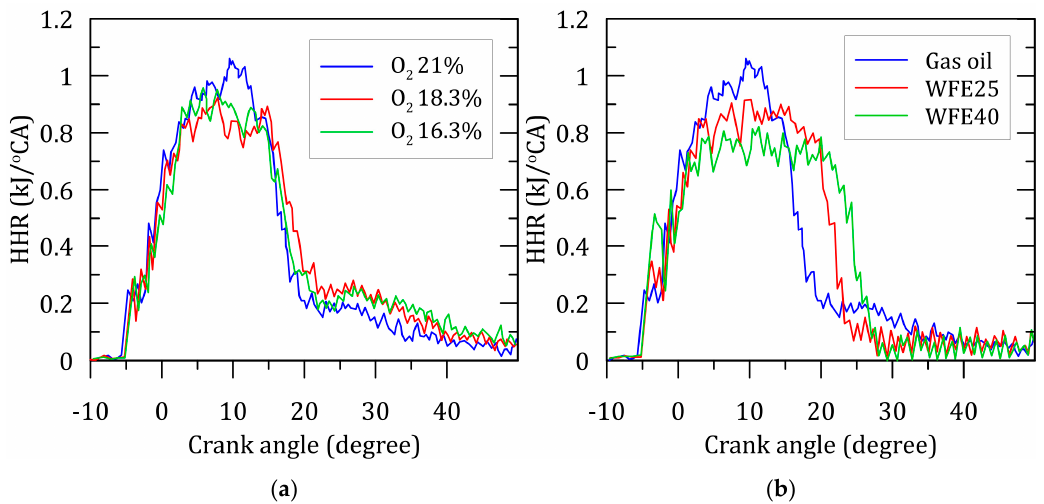
Figure 16. Experimental heat release rate versus crank angle for the two applied cases: ( a ) EGR and ( b ) WFEs. ( b )